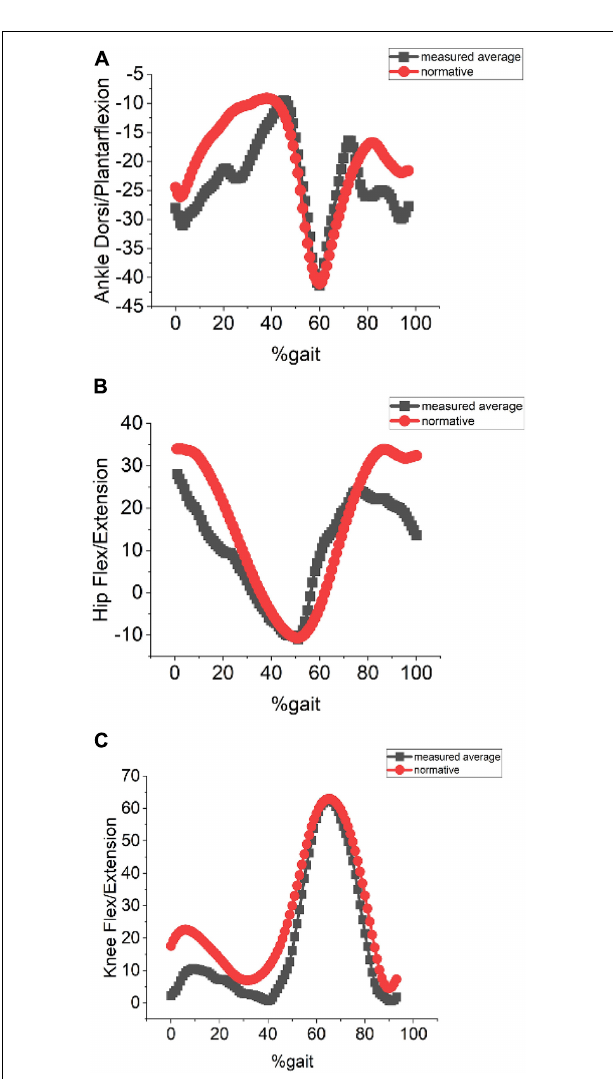
FIGURE 7 | (A) Ankle dorsi/plantarflexion. (B) Hip flex/extension. (C) Knee flex/extension measured with participant wearing non-conventional clothing and under average ambient lighting of 320